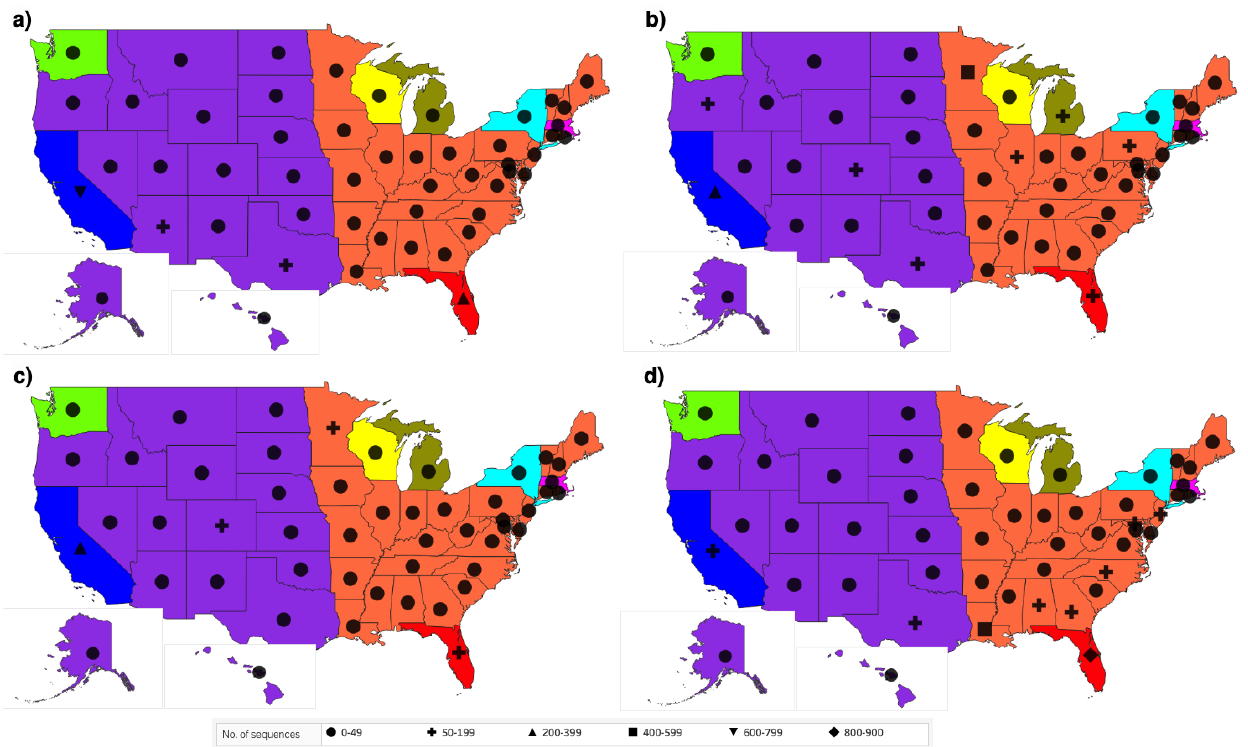
Figure 7. Geographical distribution of the Delta variant across the US for four time periods: ( a ) T6, ( b ) T8, ( c ) T9, and ( d ) T11. The legend shows the shapes representing the count of sequences that have characteristic mutations of the Delta variant. The states have been colored to correspond to the color of the states in the DiWANN networks.